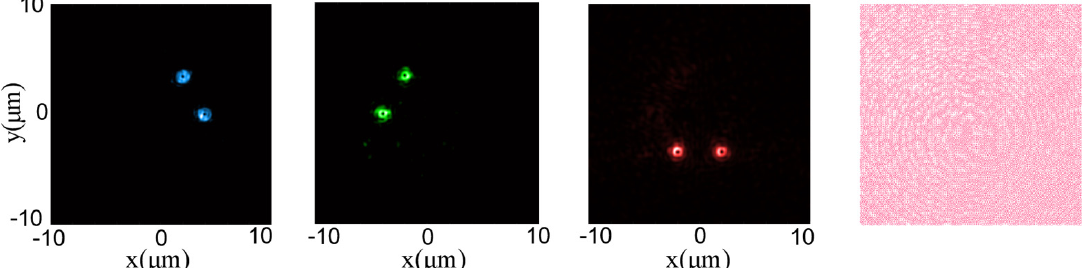
Figure 8. The first three images from left to right, respectively, represent the normalized intensity distribution of the focal planes of B, G, and R waves. The final image is the gds layout of the metalens structure